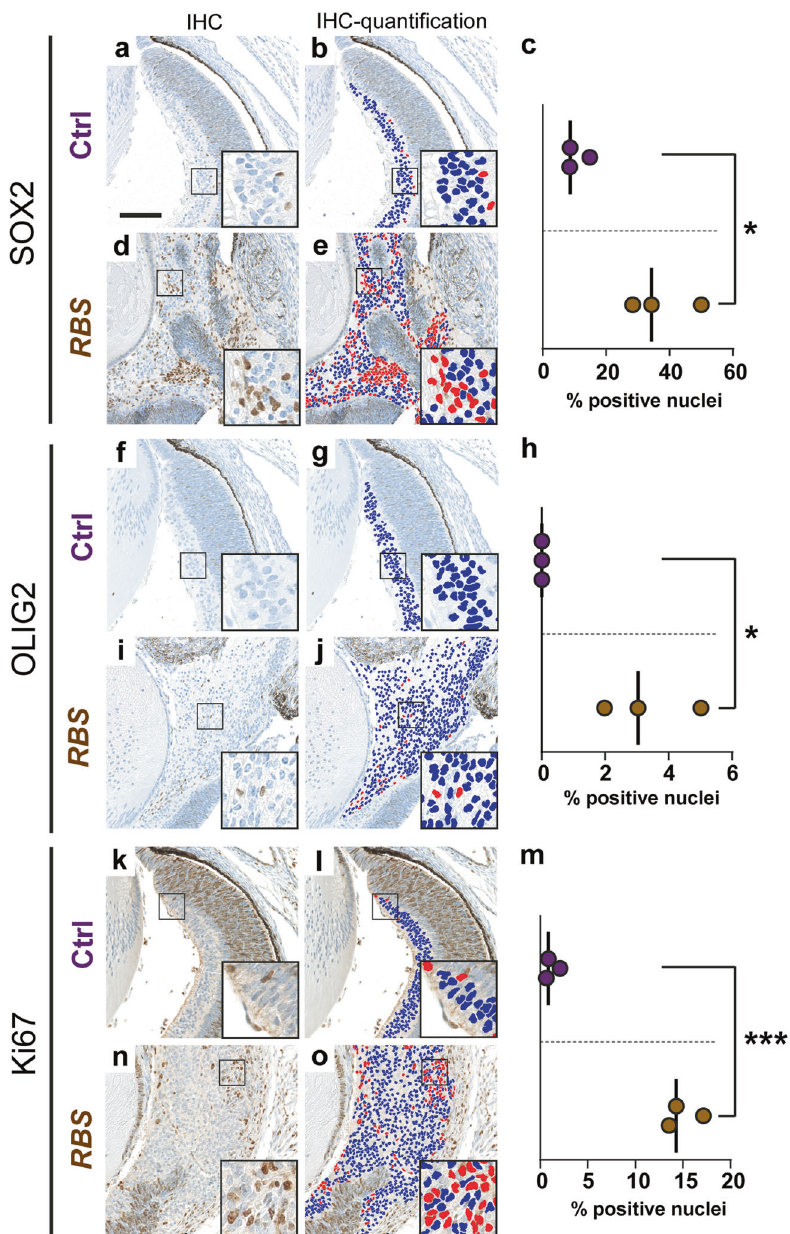
Fig. 4 Quanti fi cation of immunohistochemical nuclear staining in control retina and Rax - creER T2 ::Ctnnb1(ex3) fl / + SmoM2 fl / + ( RBS ) ocular lesions. Digitally supported quanti fi cation of SOX2 ( a – e ), OLIG2 ( f – j ), and Ki67 ( k – o ) nuclear staining in inner retinal layers of control mice ( a , f , k ) and sheet-like growing masses of RBS E8.5 ocular lesions ( d , i , n ). Nuclear signal of SOX2 ( c ), OLIG ( h ), and Ki67 ( m ) was signi fi cantly increased in mutant RBS lesions (brown) compared to control retinas (purple). Negative nuclei are labeled blue, positive nuclei are labeled red ( b , e , g , j , l , o ). In c , h , m , lines indicate medians. Asterisks indicate signi fi cance: p value <0.05*, <0.001***, two-tailed t test. Scale bar is 100